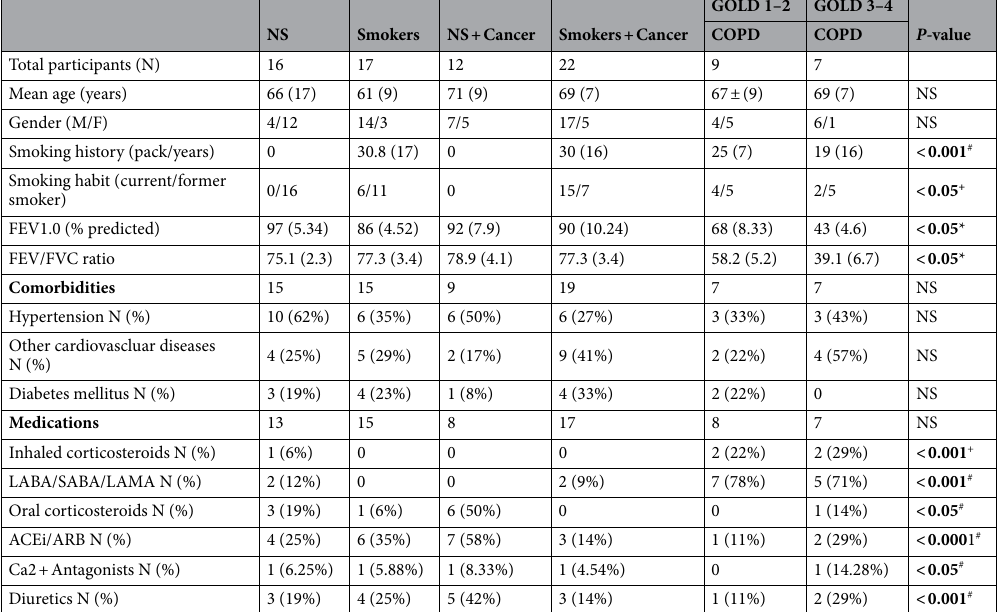
Table 3. Demographic characteristics bronchoscopy cohort (n = 83). Data are mean ± SD, unless specified. NS = Never-smokers; COPD: chronic obstructive pulmonary disease; GOLD: global initiative for chronic lung diseases. LABA: Long-acting beta-agonists; SABA: short-acting beta-agonists; LAMA: long-acting muscarinic agents; ACEi: ACE-inhibitors; ARB: angiotensin receptor blockers. * p value = GOLD 3–4 vs all the other groups, GOLD 1–2 versus NS, Smokers, Smokers + cancer, GOLD 3–4, by definition. + p value = GOLD 3–4 versus all the other groups, GOLD 1–2 versus NS, Smokers, GOLD 3–4. # p value = GOLD 3–4 versus all the other groups, GOLD 1–2 versus all the other groups. Significant values are in